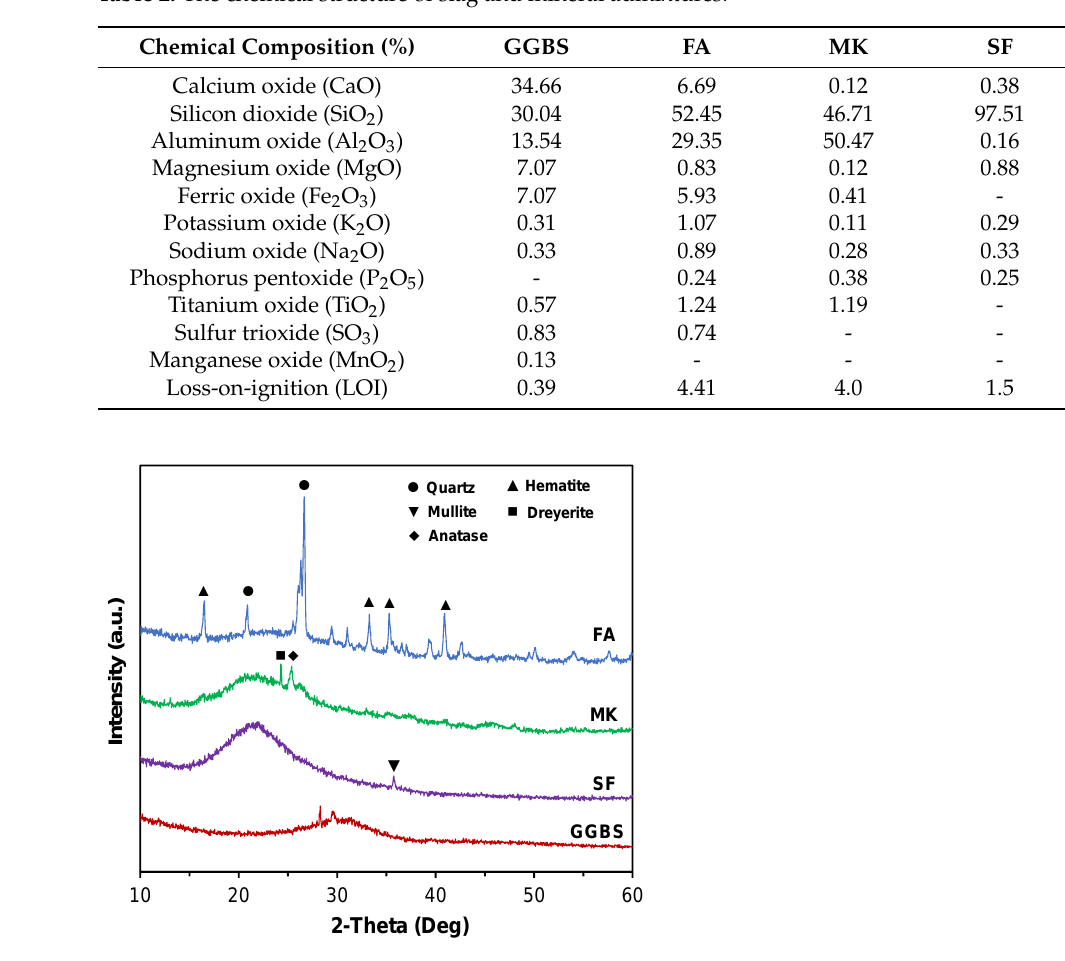
Figure 2. XRD results for GGBS and mineral admixtures.